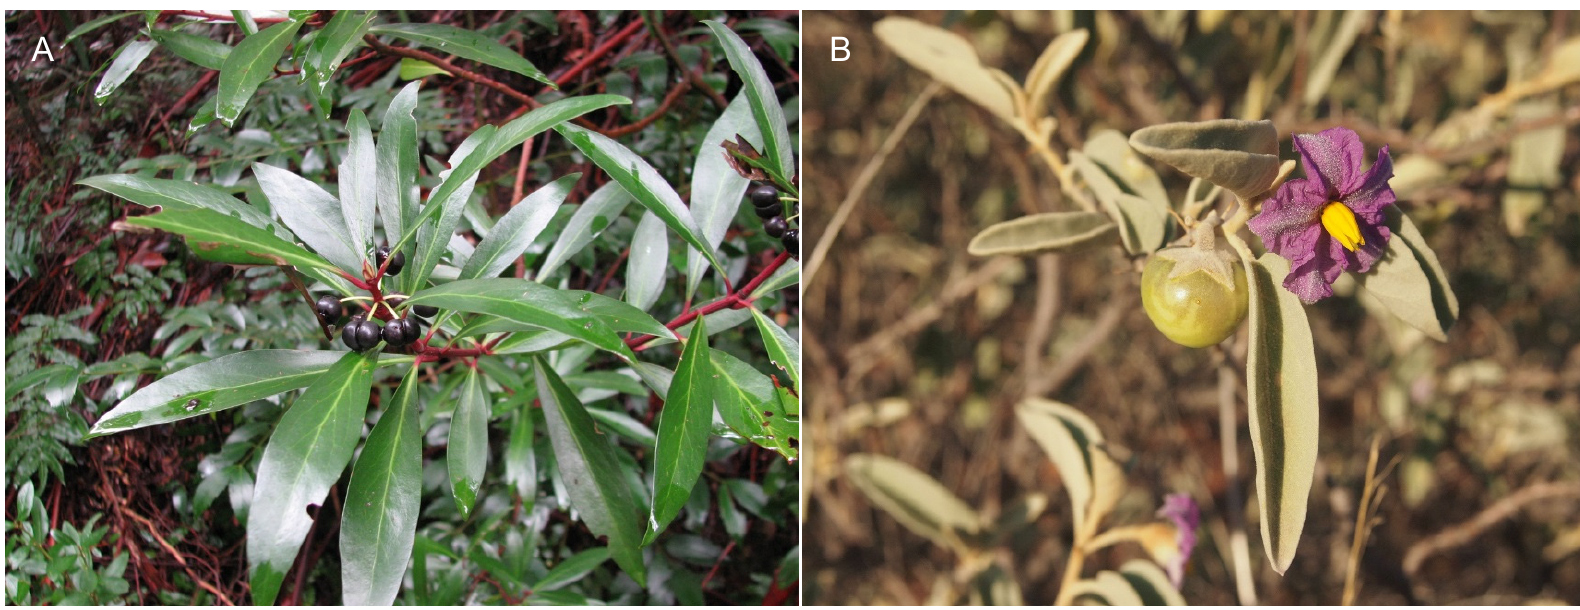
Figure 2. ( A ) Tasmannia lanceolata (Tasmanian pepper) (Credit: Mark Marathon—Own work, CC BY ‐ SA 3.0, https://commons.wikimedia.org/w/index. php?curid=28133459 ); ( B ) Solanum centrale (bush tomato) (Credit: Melburnian—Self ‐ photographed, CC BY 3.0, https://commons.wikimedia.org/w/index. php?curid=10145927).